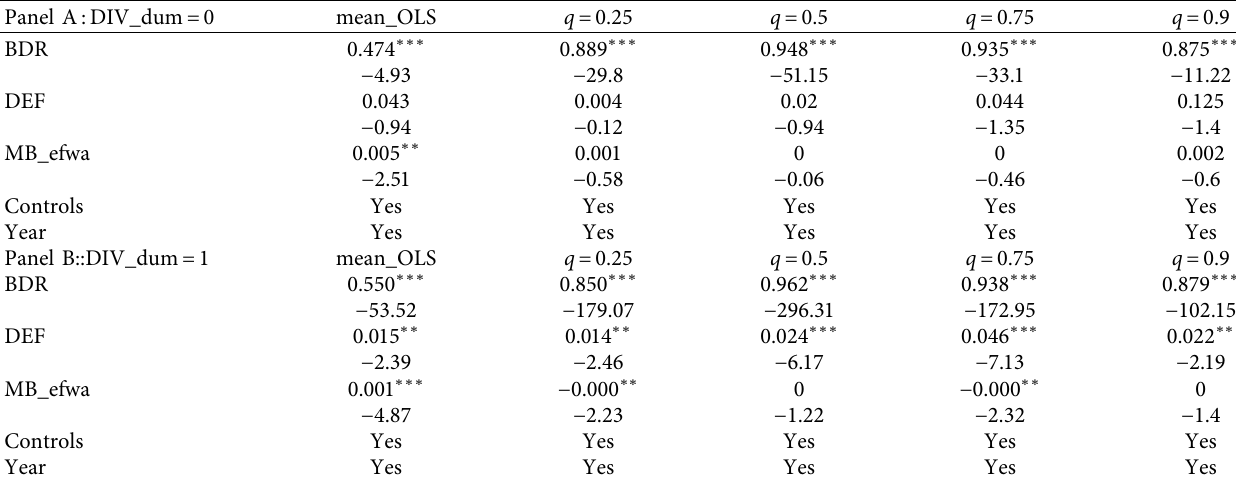
Table 6: Robustness results based on quantile